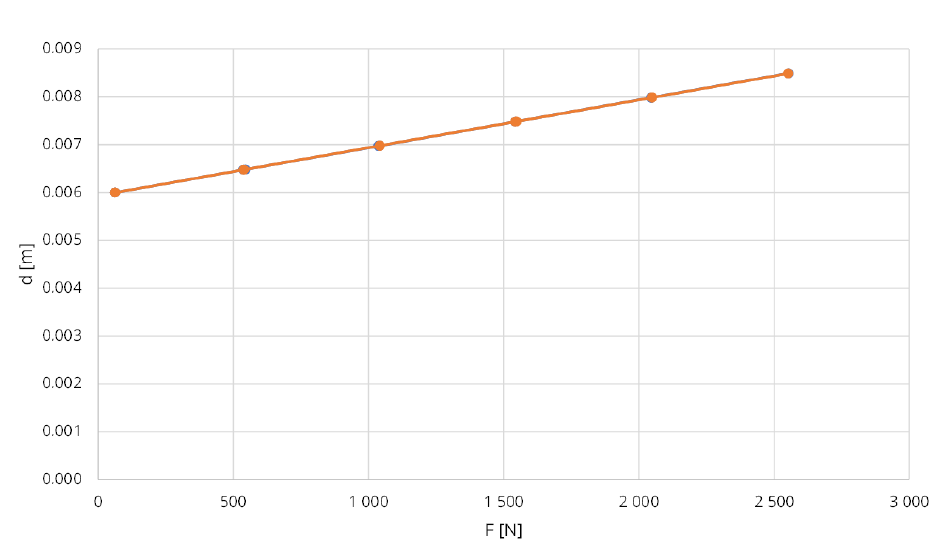
Figure 10. Two dimensional representation of the stresses in sand during the first load cycle: ( a ) vertical stresses, ( b ) horizontal stresses.